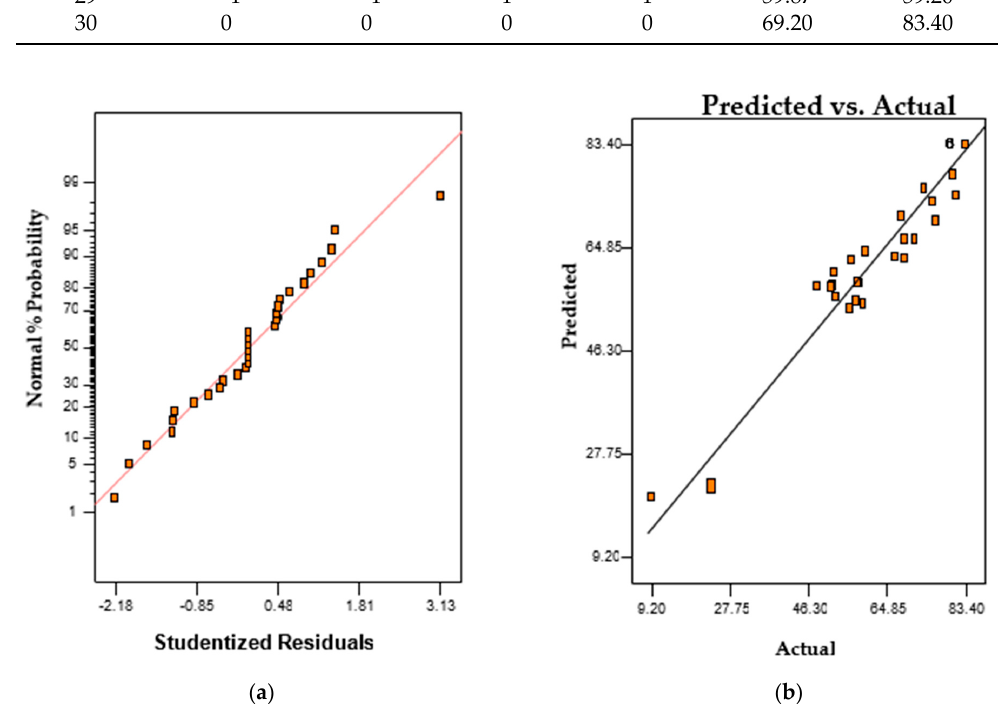
Figure 4. Relationship between outcomes: ( a ) probability coefficient and ( b ) predicted and actual.